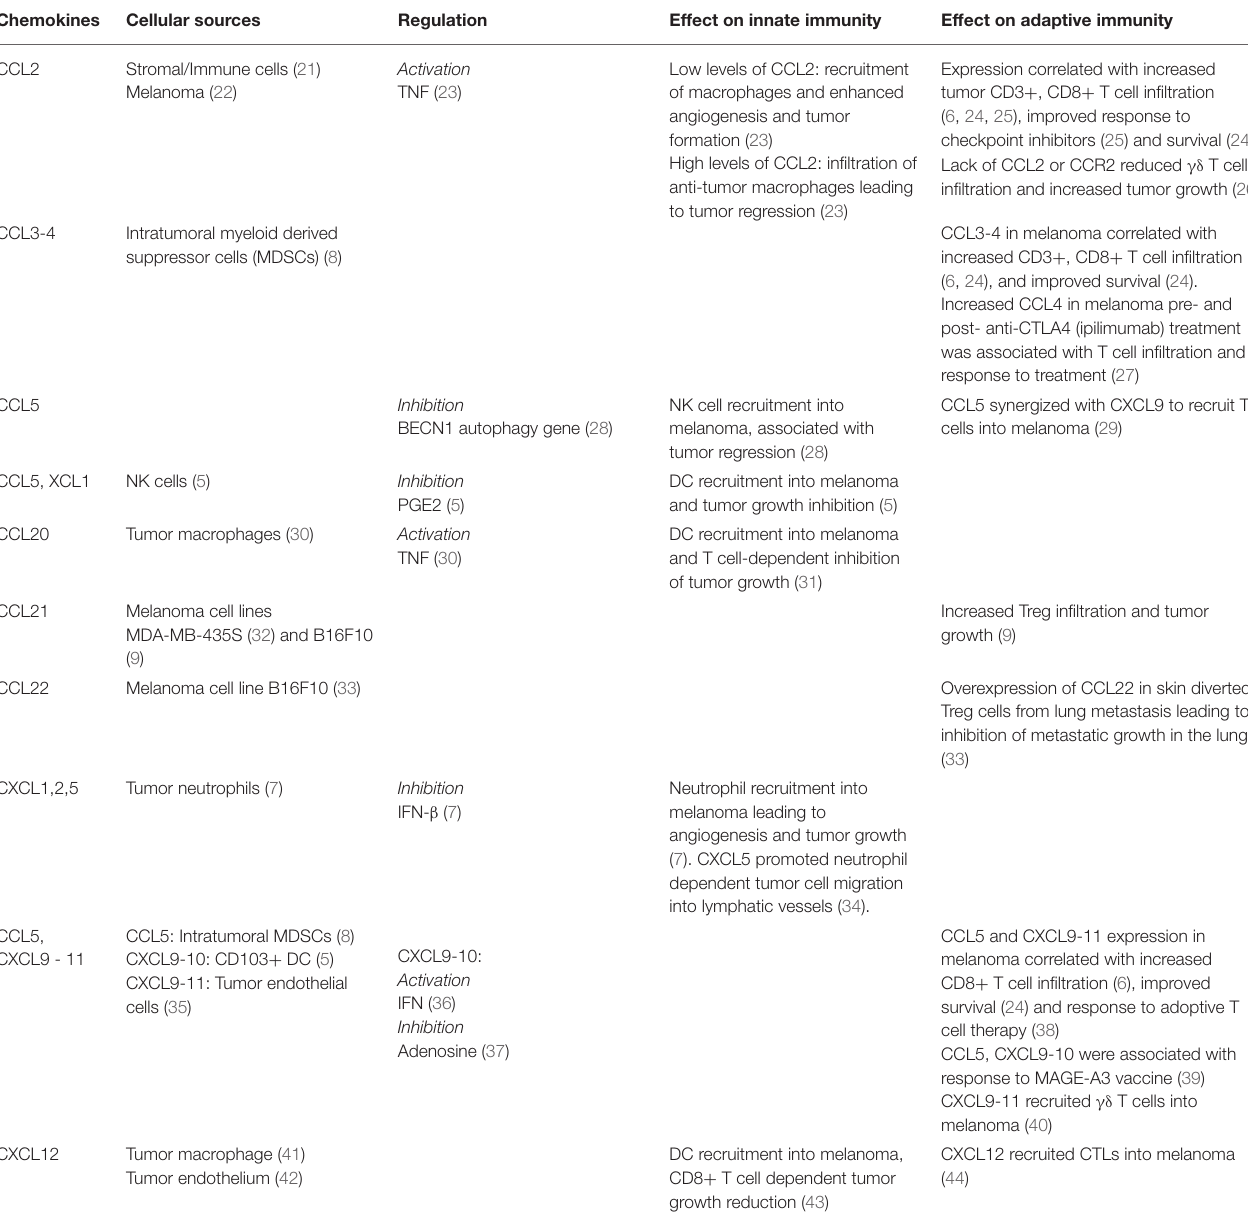
TABLE 1 | Chemokines implicated in regulating immune responses in melanoma.